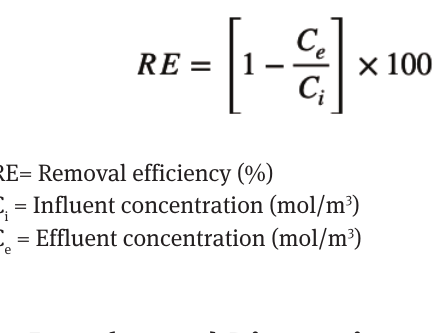
Figure 2: Cumulative target risk of cancer from microcystin-LR in drinking water throughout a 70-year